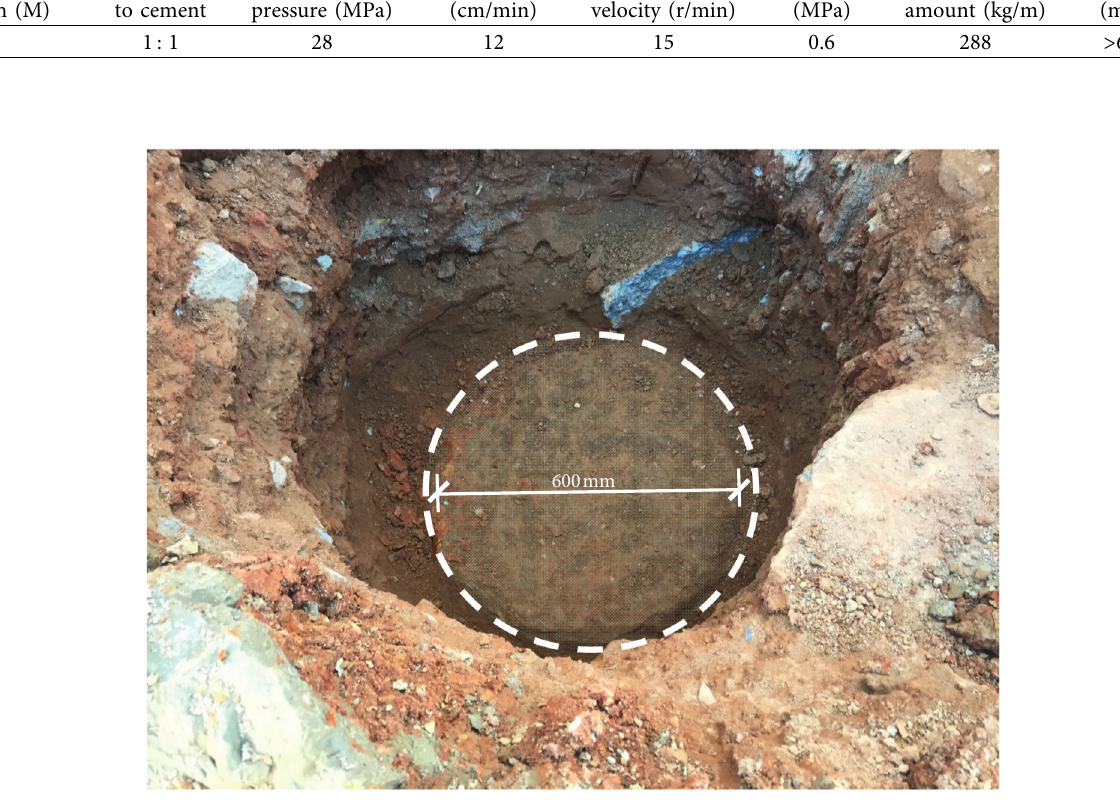
Figure 5: Diameter of the in situ test pile.